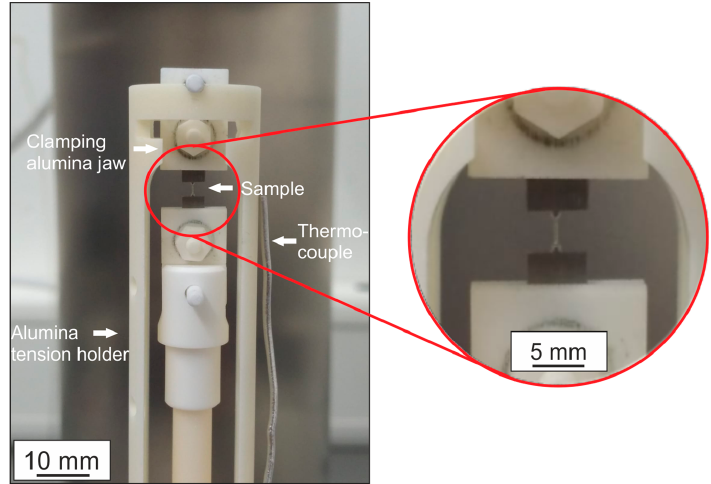
Figure 1. Thermomechanical analyzer (TMA) setup: alumina tension holder, pushrod and clamping jaw for mounting the sample. The polished tensile specimen has a diameter of 450 µm over the entire gauge length of 2500 µm before creep testing.